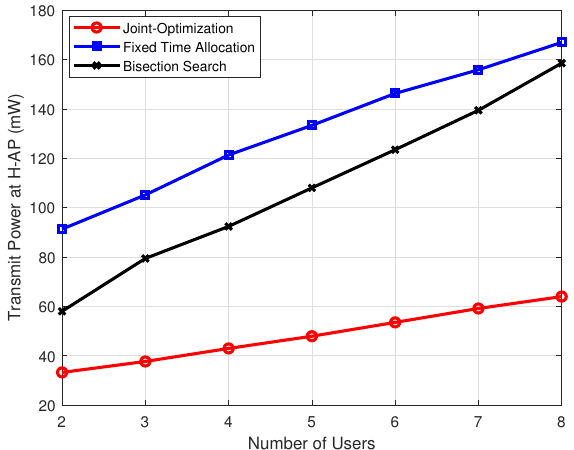
Figure 4. Transmit power versus the number of users when M = 10.